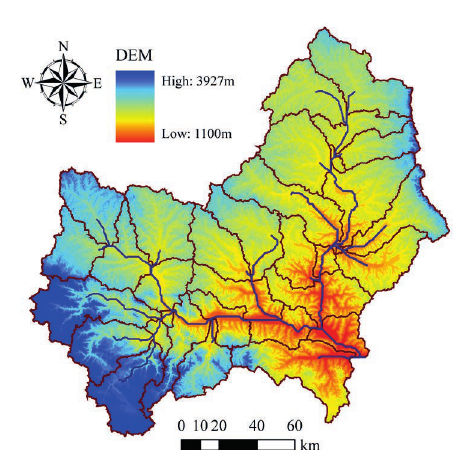
Fig. 1 The DEM of the Wei River Basin in China.